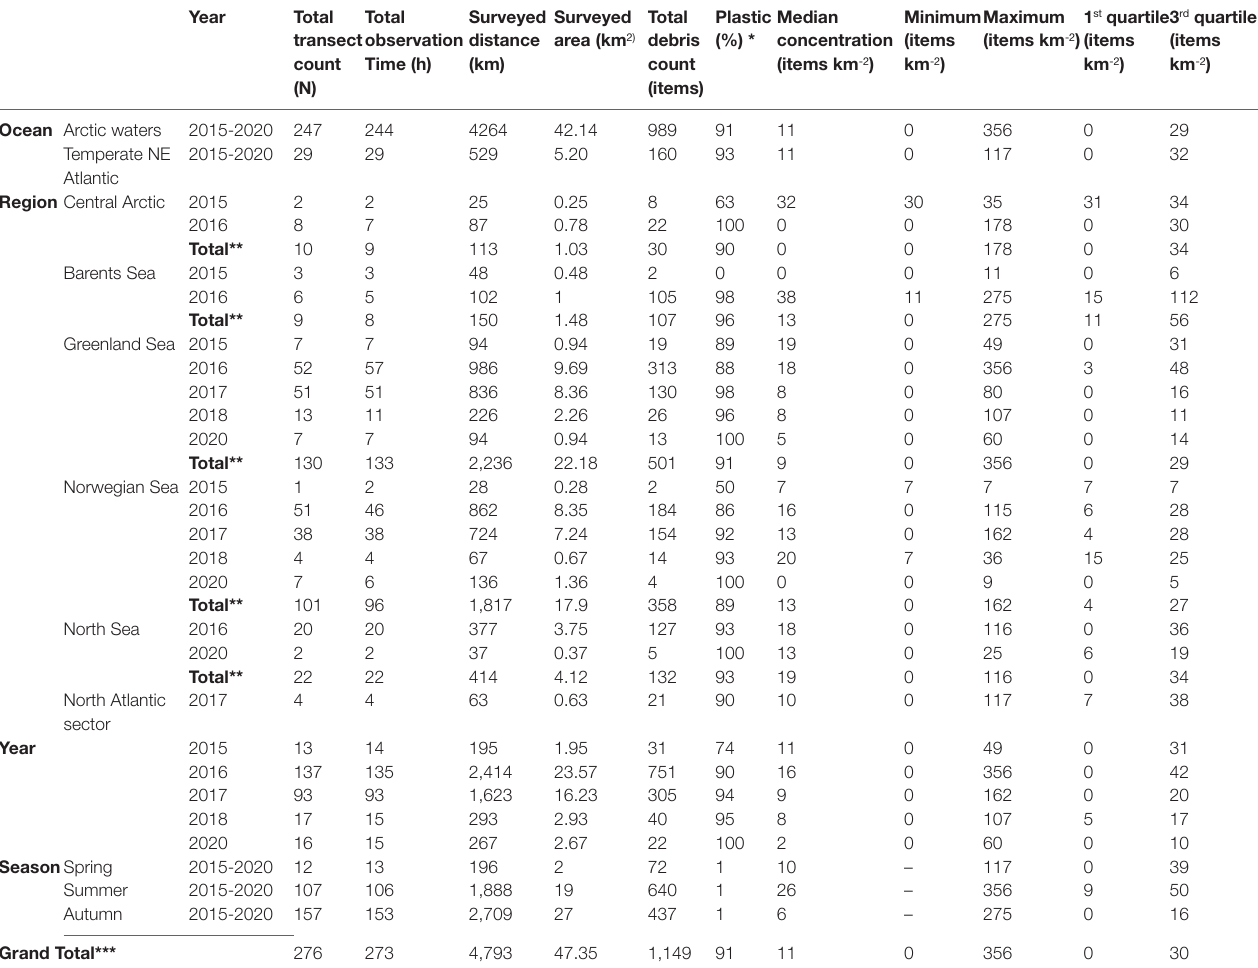
TABLE 1 | Concentrations of floating marine debris in different regions, years and